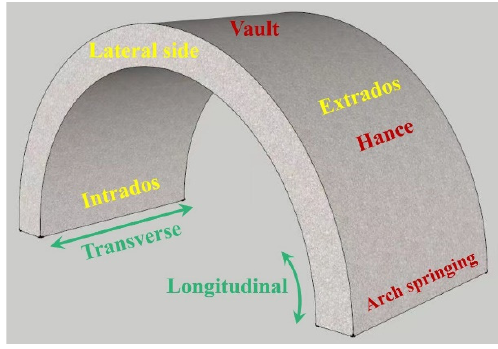
Figure 3. Concrete arch structure.